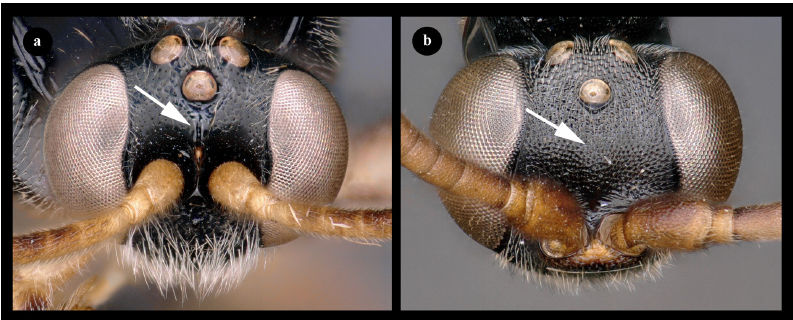
lamellate structure on frons (compared to lack of lamella on frons in Fig. 5b).